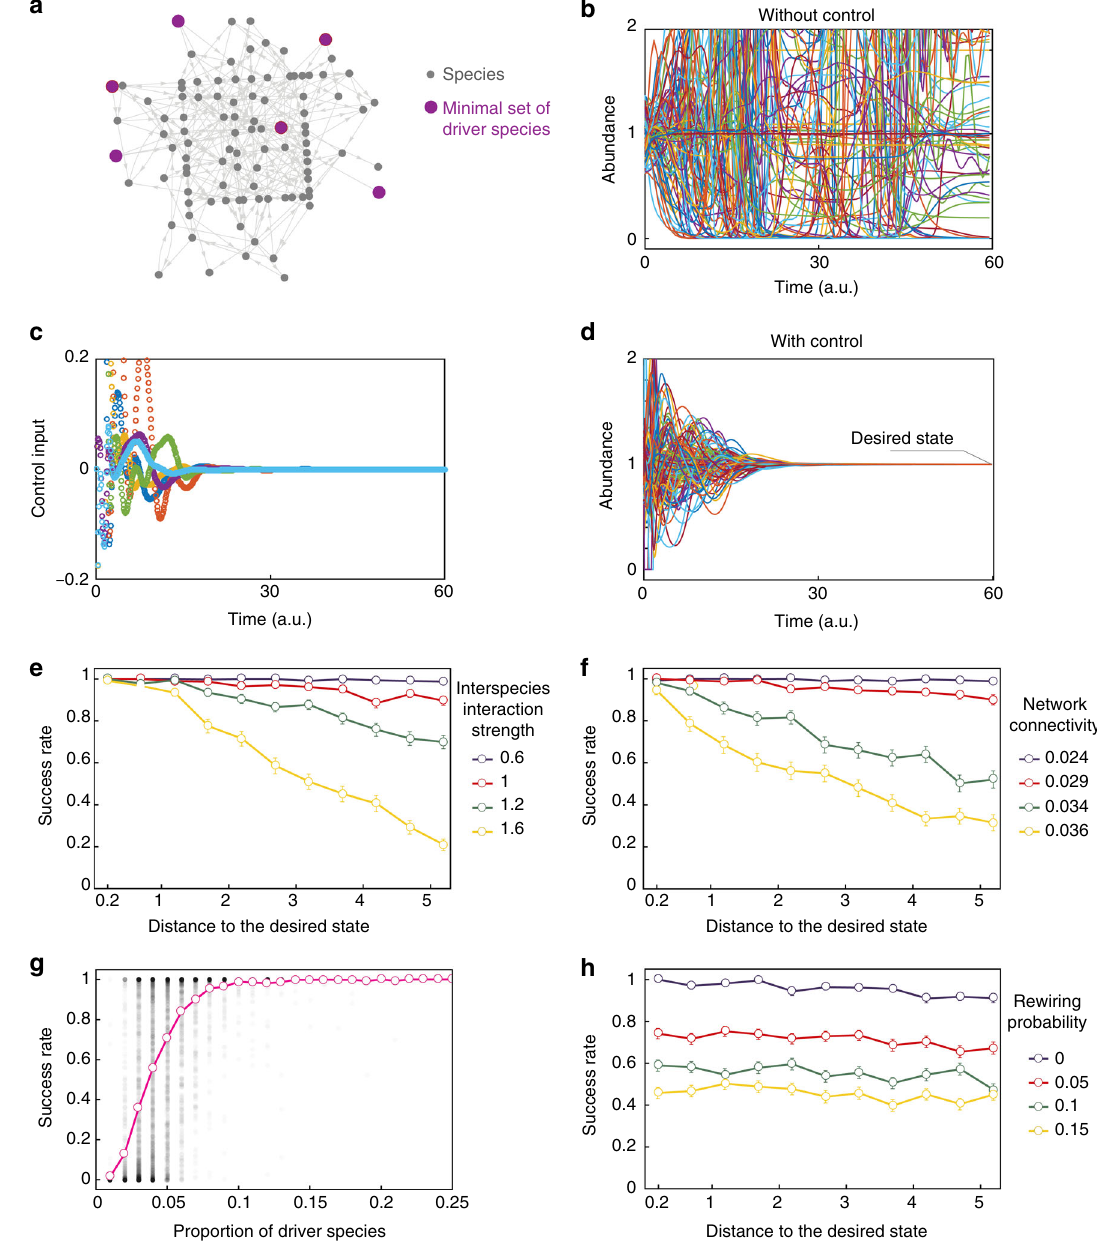
Fig. 5 Numerical validation on large microbial communities. a Example of the ecological network for a random microbial community with N = 100 species ( c = 0.03). A minimum set of M = 6 driver species is shown in purple. The desired state is chosen as x x d = 0.4 from the desired state, the uncontrolled microbial community does not reach x 0 at distance as in panel ( b ), we apply the control input generated by the linear MPC (panel c ) to the six identi fi ed driver species. This control strategy drives the community to x d (panel d ). e , f , h Mean success rate as a function of d . Error bars denote the standard error of the mean. Parameters are: c = 0.025, θ = 0.05 for panel ( e ), σ = 0.8, θ max = 0.05 for panel ( f ), and c = 0.025, σ = 0.8, θ max = 0.05 for panel ( h ). g Success rate as function of the proportion max M / N of driver species. Black dots show the success rate of 7700 random communities. Pink shows the mean success